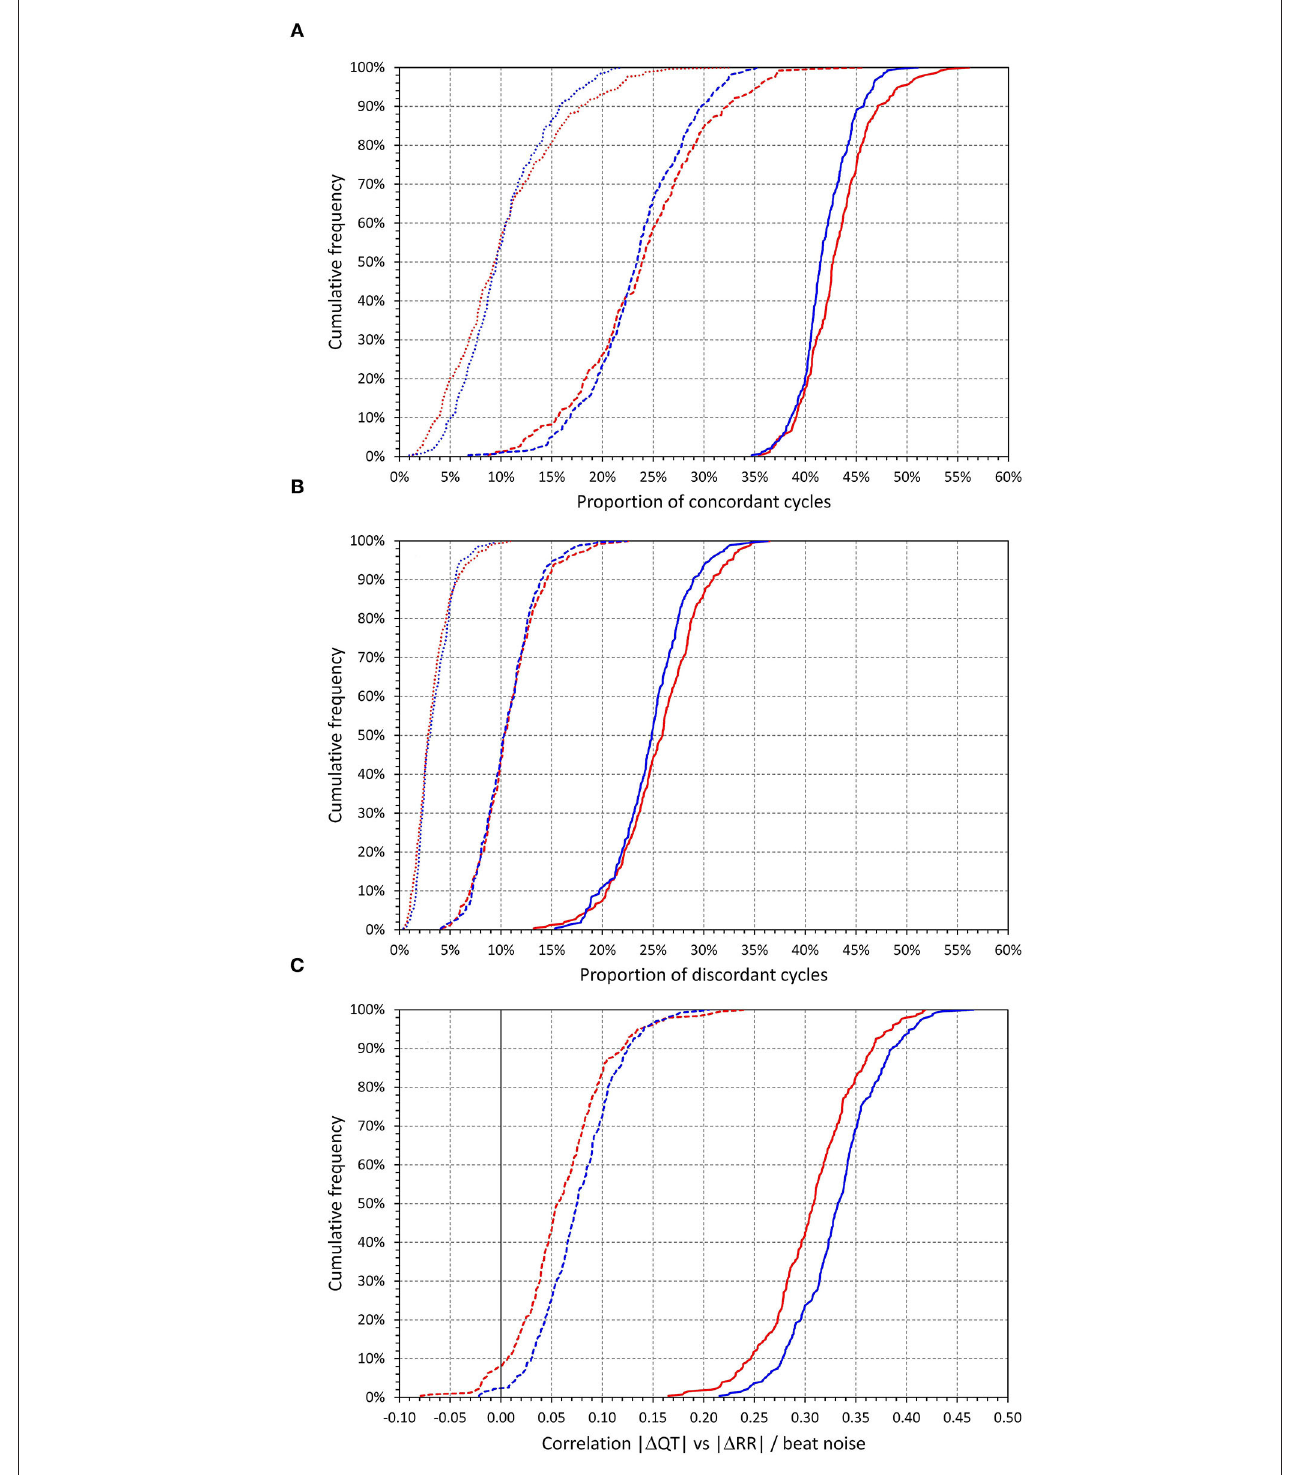
FIGURE 5 | Cumulative distributions of the intra-subject proportions of concordant beats [top (A) ], the proportions of discordant beats [middle (B) ], and of the intra-subject correlations between | 1 QT| and | 1 RR|, and between | 1 QT| and beat noise [bottom (C) ]. In the upper two panels, the solid lines, dashed lines, and dotted lines correspond to all concordant/discordant beats, concordant/discordant beats for which | 1 RR| > 20ms, and concordant/discordant beats for which | 1 RR| > 50ms, respectively. In the bottom panel, the solid and dashed lines correspond to intra-subject correlations | 1 QT| vs. beat noise, and intra-subject correlations | 1 QT| vs. | 1 RR|, respectively. In all panels, the red and blue lines correspond to females and males, respectively.